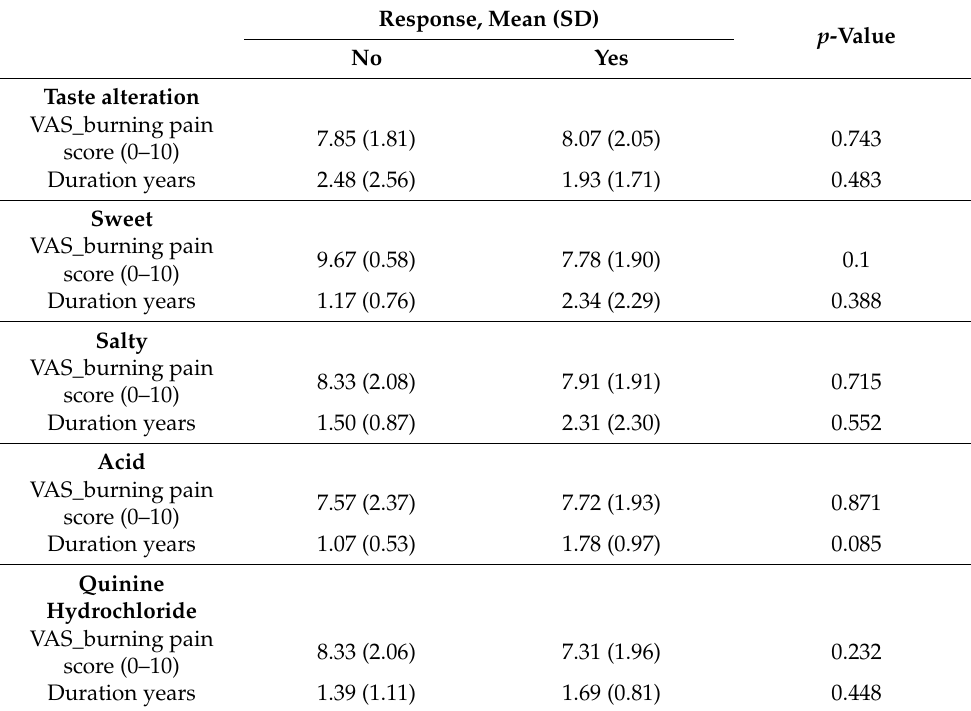
Table 2. Taste examination in patients with burning mouth syndrome